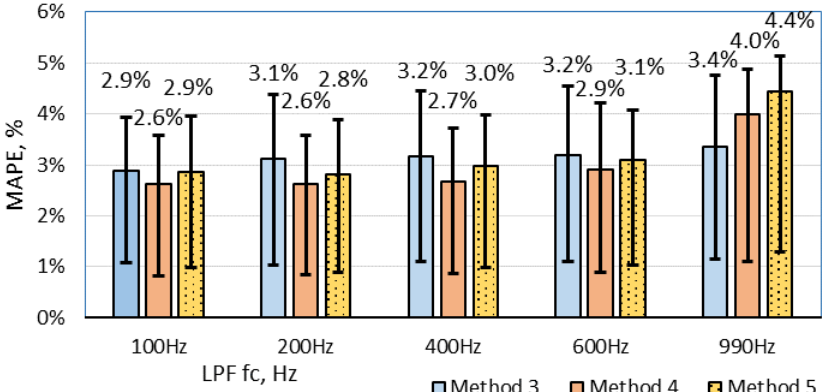
Figure 8. An estimated speed MAPE as a function of LPF cut-off frequency with three different methods. Error bars indicate a percentage error range of second and third quartiles.